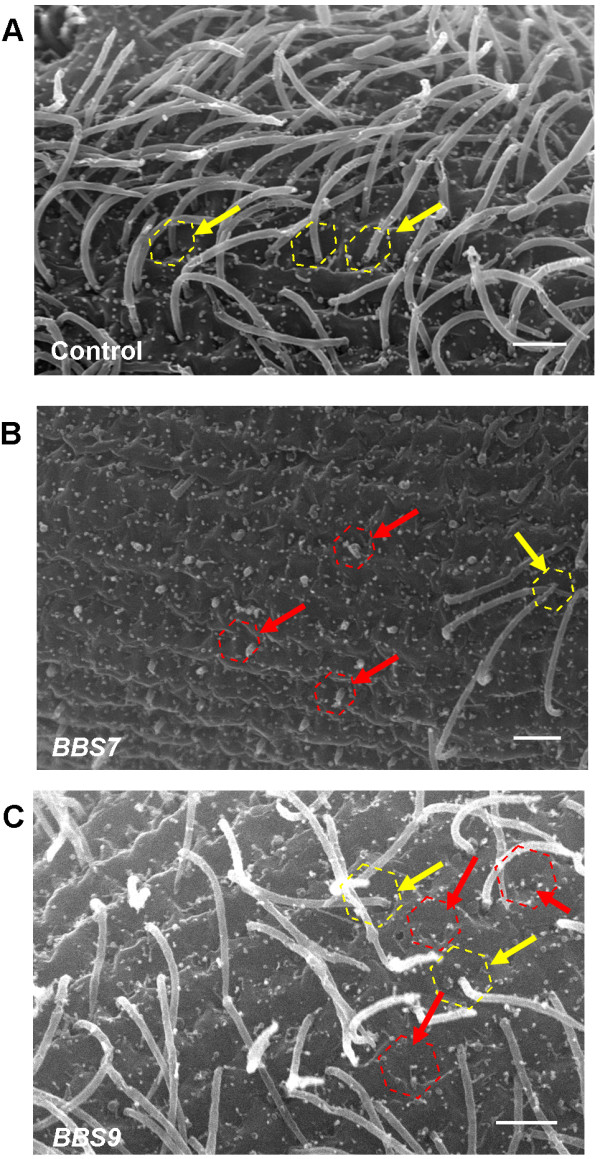
Scanning electron micrographs of cilia and cell surfaces. (A) Control cell; yellow dotted hexagon and arrows emphasize cortical units with a cilium arising from the center. (B) BBS7- depleted cell. (C) BBS9-depleted cell. Red dotted hexagons and red arrows indicate cortical units with short cilia arising, or no cilia. Note these cells contain cortical units with average length cilia arising (yellow dotted hexagons and yellow arrows). These are representative images, scale bars represent 2 μm.